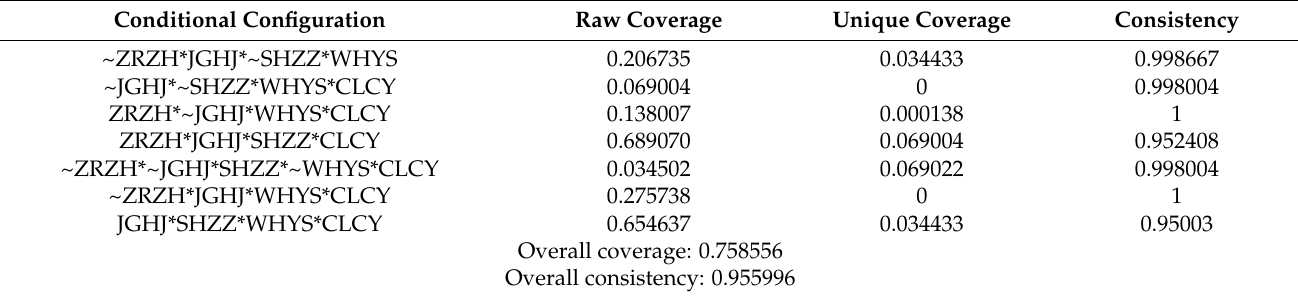
Table 8. Complex